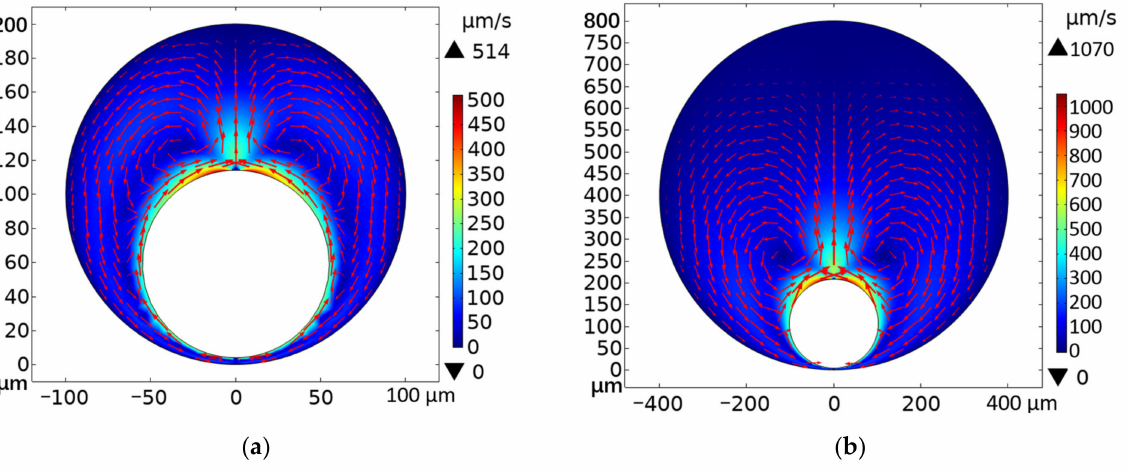
Figure 7. Simulated 2D convective velocity maps for microbubbles generated in capillary tubes. The arrow indicates the direction of the flow field and the color indicates the velocity